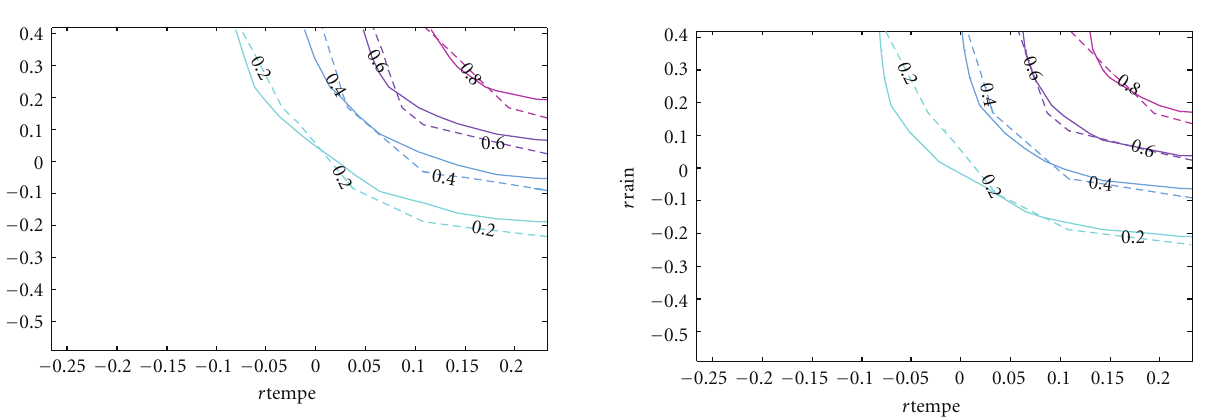
Figure 9: Real versus Gauss fitted CDF. Note: The dashed lines are the real CDFs while the solid lines are the simulated CDFs.